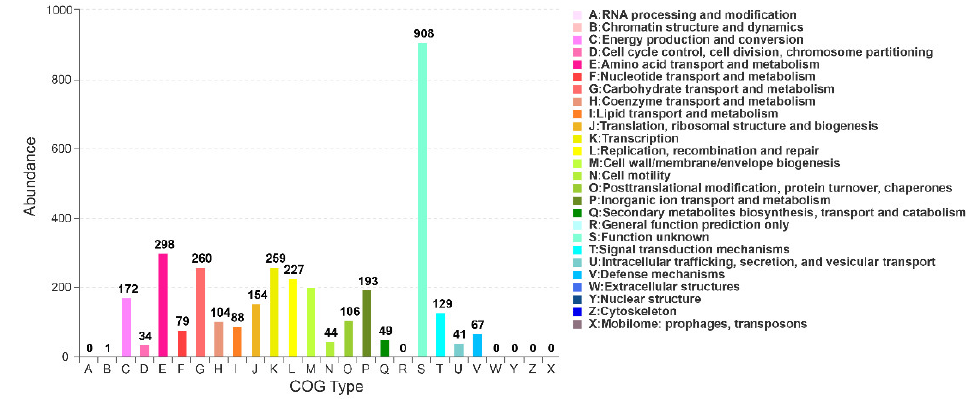
Figure 5. COG annotation classification of the B. subtilis A-5 genome.